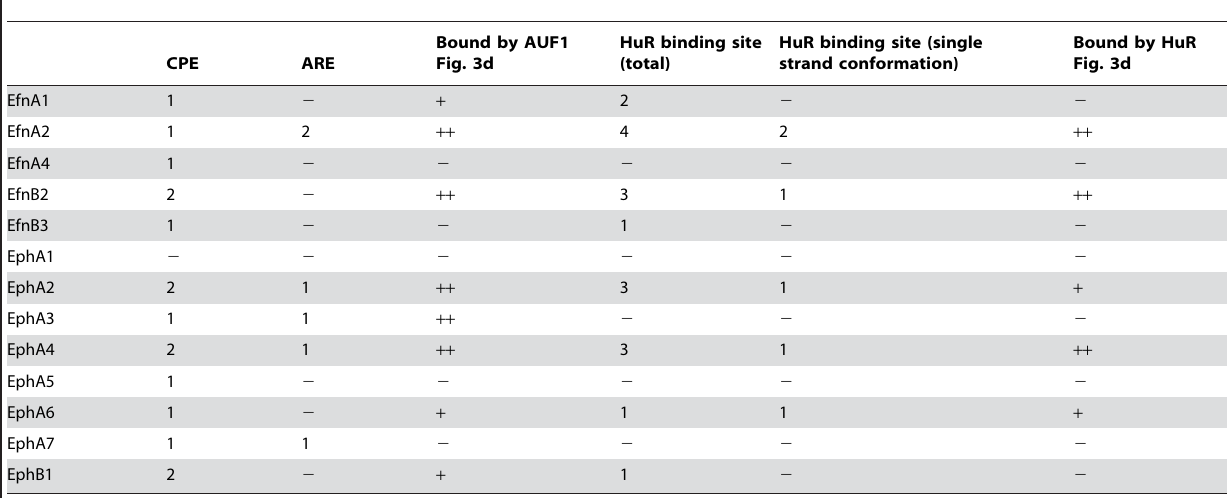
Table 2. Motifs in biotinylated probes used for RNA-protein pulldown assay and binding patterns of AUF1 (p42/p45) and HuR.